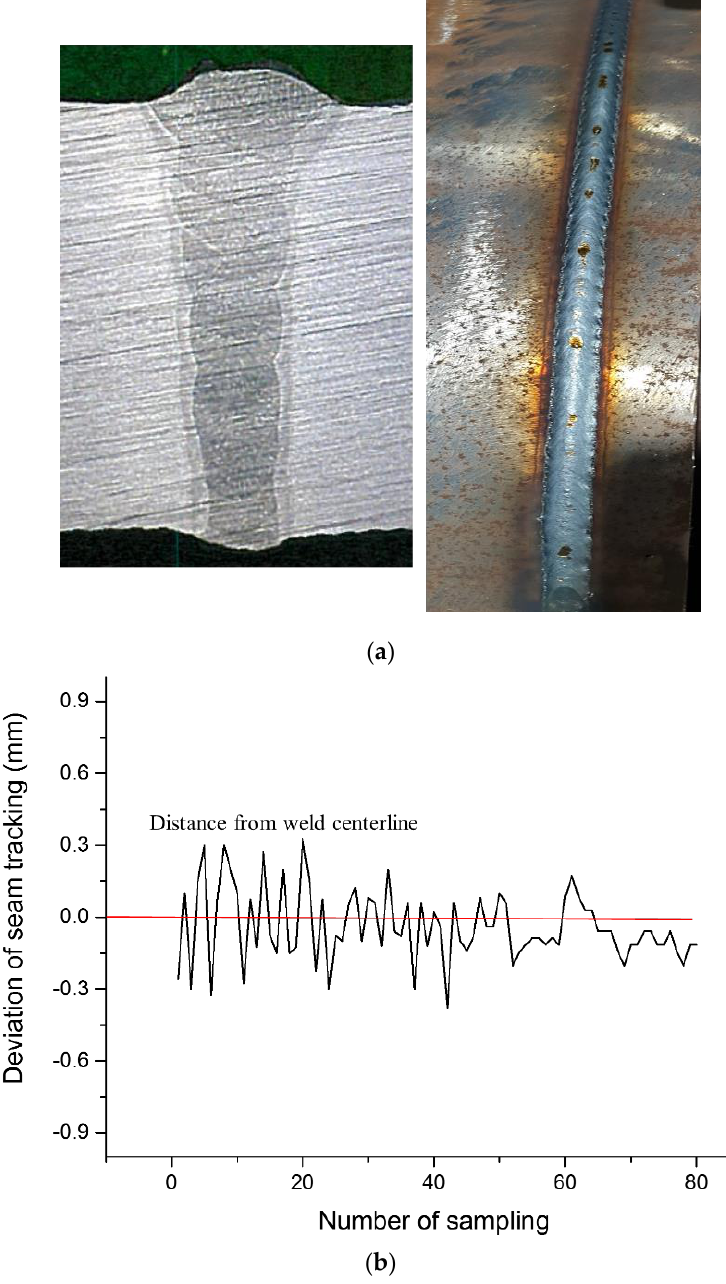
Figure 17. Results of welding seam tracking: ( a ) Welding bead shape with fusion zone and ( b ) deviation of seam tracking in fill pass welding.